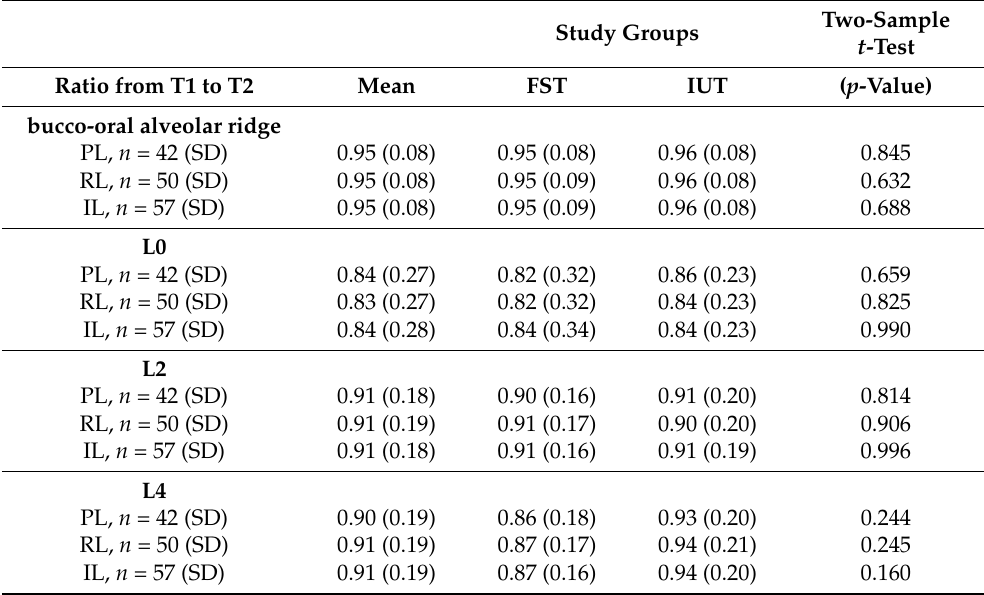
Table 5. Ratio of residual ridge width of the bucco-oral alveolar ridge and buccal lamella from T1 to T2